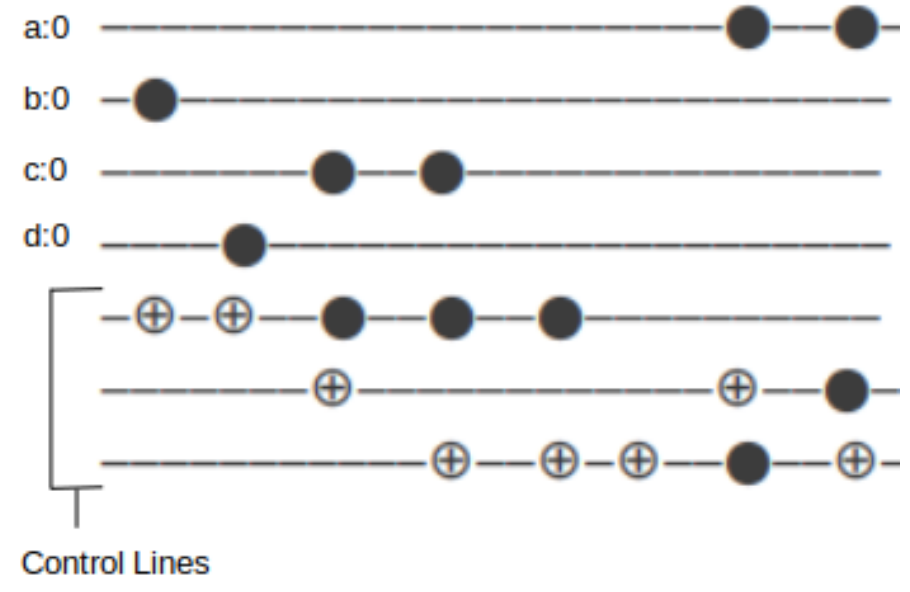
Figure 11. Circuit of Benchmark